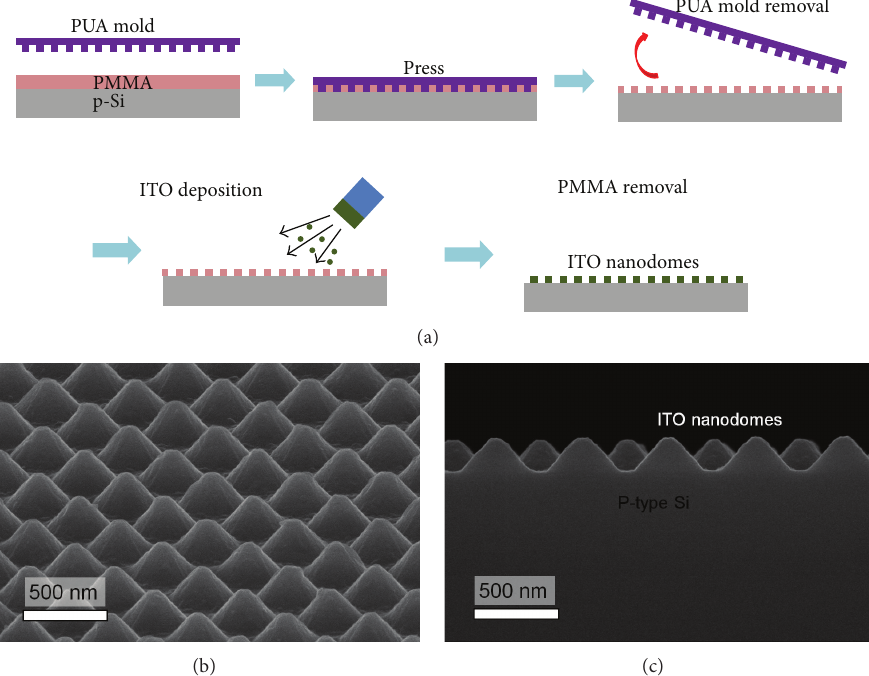
Figure 2: (a) Schematic illustrations of processing steps of preparing ITO nanodomes; (b) SEM image of nanodomes at top view; (c) SEM image of nanodomes at cross-sectional view [6].